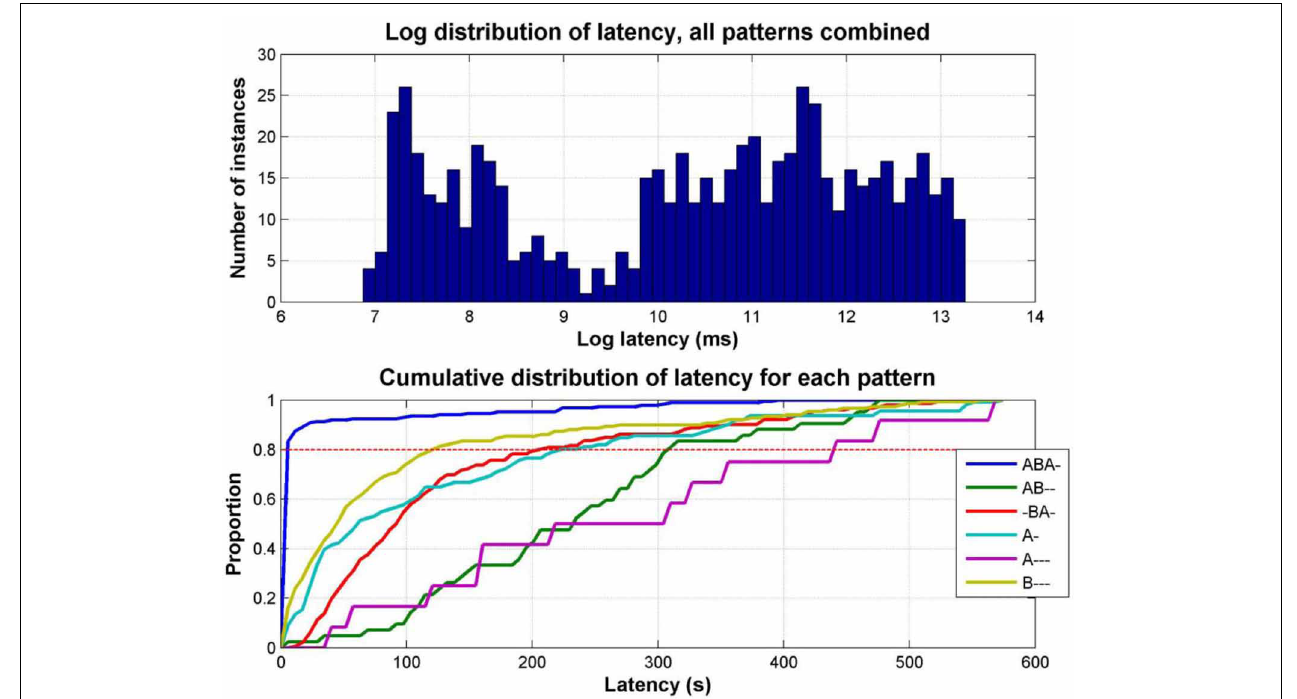
FIGURE 8 | Distribution of response latencies. Top: Distribution of latencies for all patterns combined, for all data in Experiment 1; for clarity latency is plotted as the log of the latency in milliseconds. Bottom: Cumulative distribution of latency for each pattern separately, combining data from all participants and sessions. Each line represents